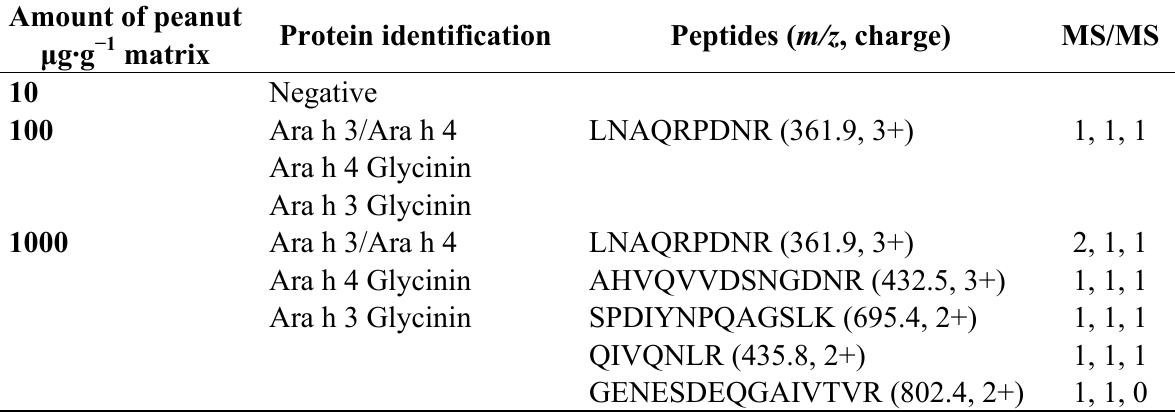
Table 5. DDA MS/MS results for 16 min baked cookies incurred with trace amounts of peanuts (0–1000 μ g·g − 1 matrix) after protein enrichment via peptide ligand